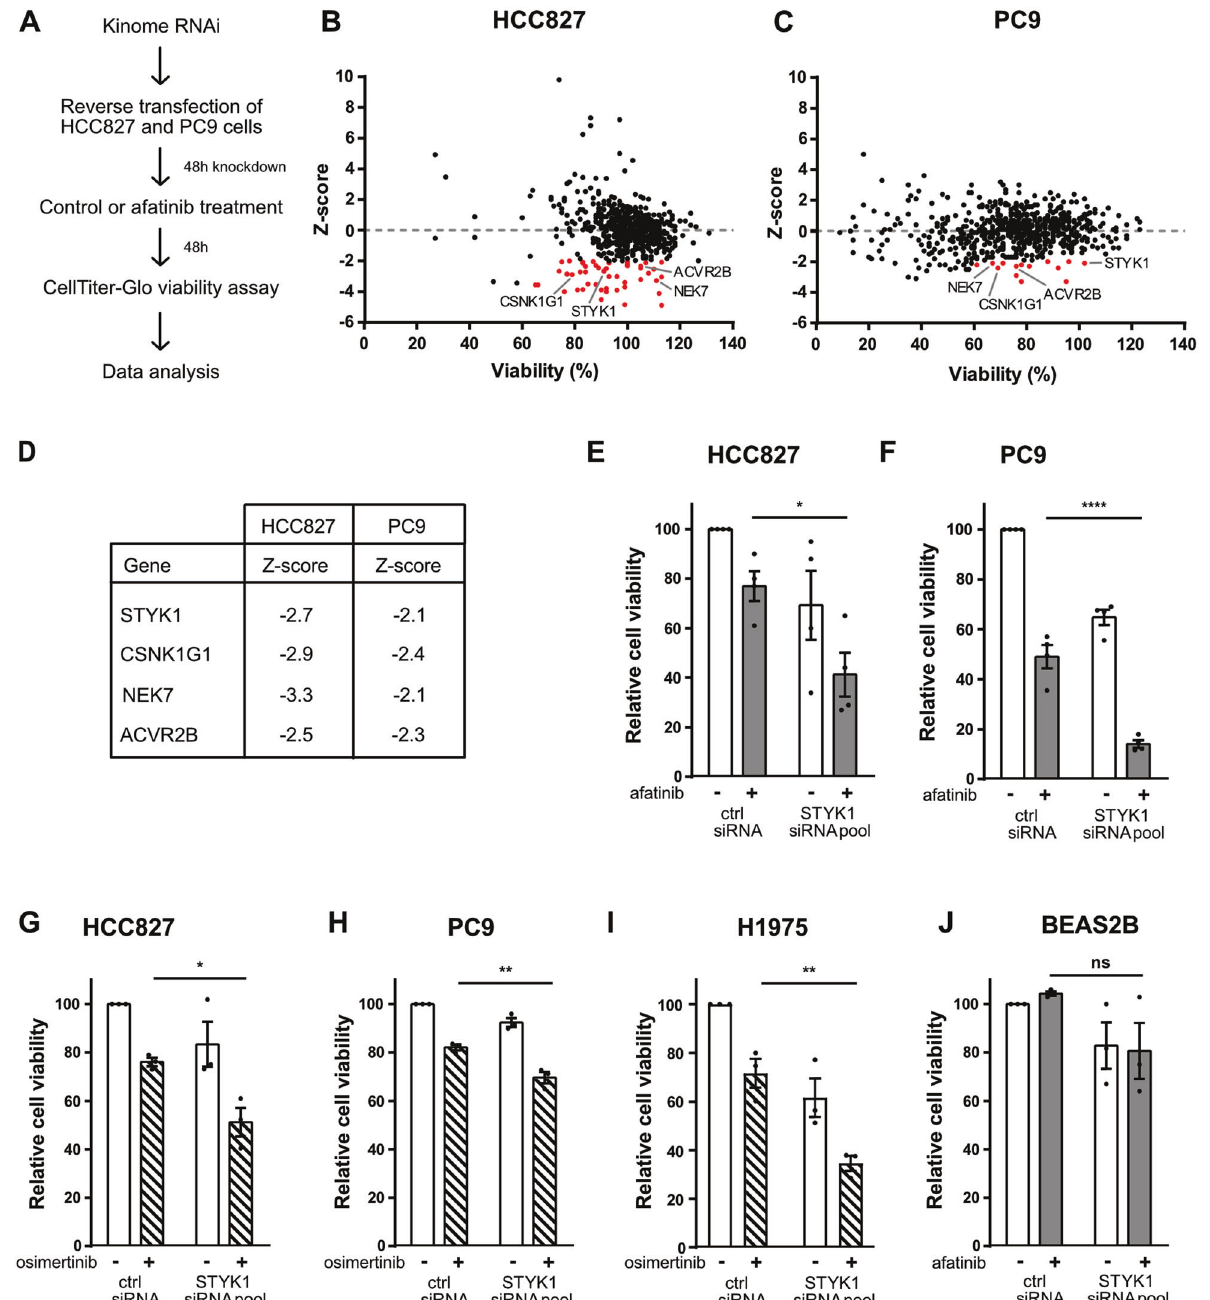
Fig. 1 STYK1 supports a prime mechanism of innate tolerance to afatinib in EGFR mutant NSCLC cells. A Schematic representation of the kinome-wide RNAi screen. HCC827 and PC9 were reverse transfected with a custom-made siRNA kinome library and 48 hours post- transfection cells were treated with control (DMSO) or afatinib (1 nM or 5 nM for HCC827 or PC9, respectively). Cell viability was measured after an additional 48 h of incubation. B , C RNAi screen results in HCC827 ( B ) and PC9 ( C ) cells. siRNA pools with Z-scores < − 2.00 and effects on viability >60% are indicated as red dots. D Common hit targets between HCC827 and PC9 with their respective Z-scores. E – J Cell viability analysis after reverse transfection of non-targeting control or STYK1 (pool) siRNAs treated for 48 h with control, afatinib or osimertinib. E HCC827 and F PC9 cells were treated with 1 nM and 5 nM afatinib, respectively. G HCC827 and H PC9 cells were treated with osimertinib (5 nM). I H1975 cells were treated with 10 nM osimertinib. J BEAS-2B cells were treated with 35 nM afatinib. Bars represent mean viability ± SEM. At least three independent experiments were between mutant EGFR ( Δ E746-A750 and L858R) and STYK1 (Fig. 3E, mutants. We detected a strong interaction between STYK1 and the F). The interaction between STYK1 and endogenous mutant EGFR mutant variants of EGFR by immunoprecipitating either EGFR or was con fi rmed by immunoprecipitating mutant EGFR from NSCLC STYK1, and while STYK1 also interacted with WT EGFR it was with cells overexpressing STYK1 (Fig. 3F & Suppl. Fig. 2A). Altogether, our reduced af fi nity compared to mutant EGFR (Fig. 3C, D). Interestingly, fi ndings indicate that STYK1 and (mutant) EGFR colocalize and EGFR inhibition by afatinib or osimertinib disrupted the interaction